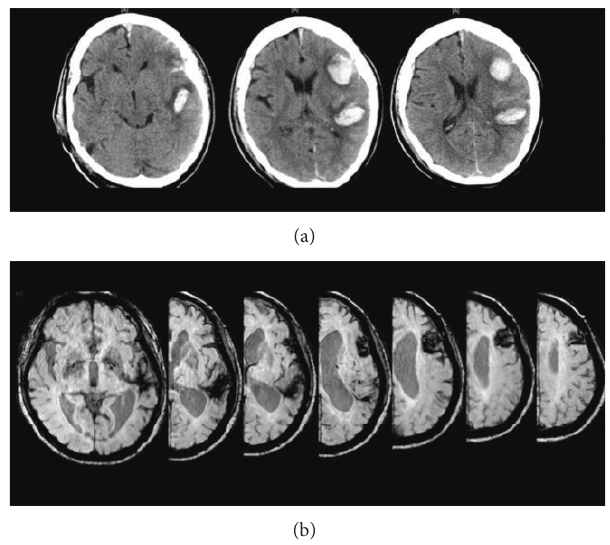
Figure 1: CT scans of the trilingual patient carried out in the acute phase following brain damage reporting the two brain lesions in the left hemisphere (a). MR scanning performed in the chronic phase revealing the extension of the two lesions is illustrated in